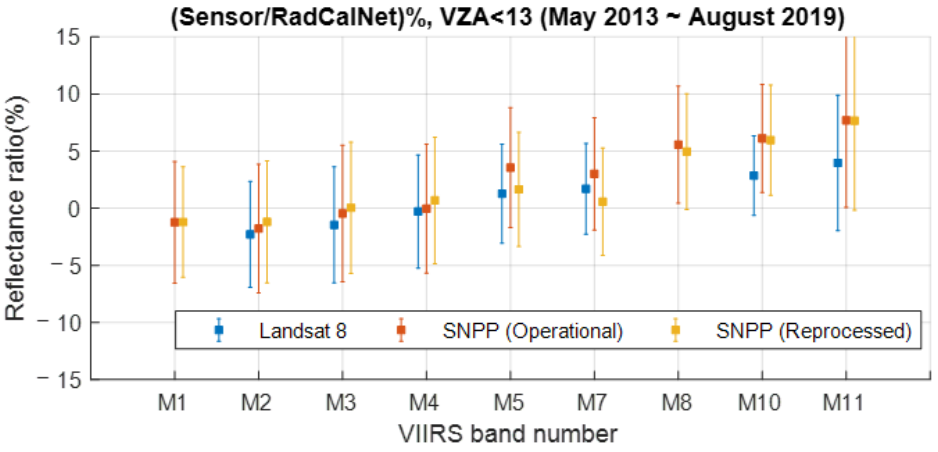
Figure 5. The average reflectance ratio percentage between RadCalNet with Landsat 8/OLI, and operational and reprocessed SNPP/VIIRS at RVUS from May 2013 to August 2019. Table 3. The mean and standard deviation of the reflectance ratio percentage between RadCalNet with Landsat 8/OLI, and operational and reprocessed SNPP/VIIRS at RVUS from May 2013 to August